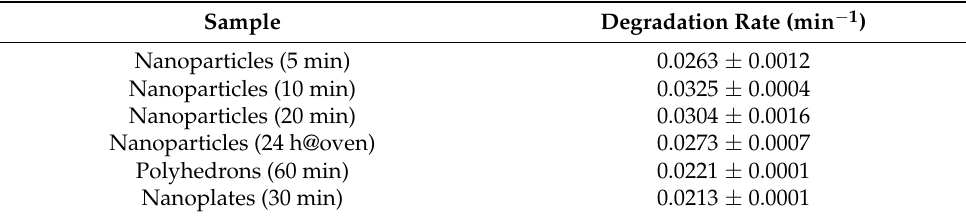
Table 4. Degradation rates of RhB in the presence of each ZTO nanostructures under sunlight.